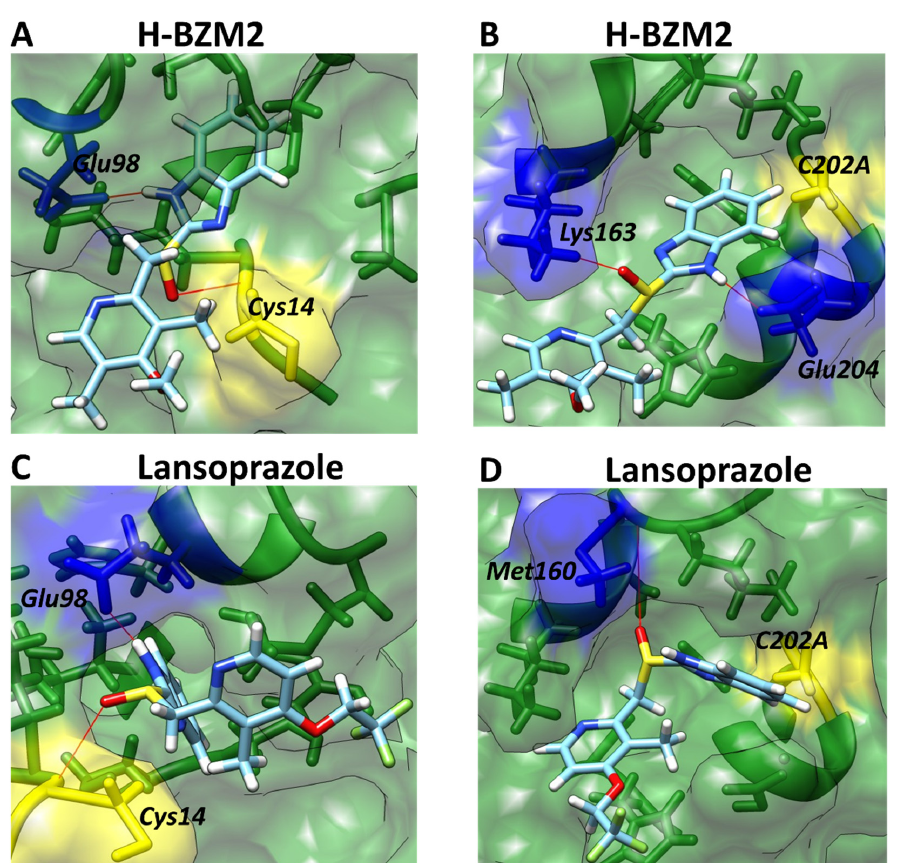
Figure 11. Prediction of docking between TPI protein (PDB entry 4BI7) and H-BZM2 and lansoprazole: 3D representations of the binding model of H-BZM2 in the vicinity of ( A ) Cys14 and ( B ) C202A, and of lansoprazole in the vicinity of ( C ) Cys14 and ( D ) C202A of TPI from G. lamblia . The interactions are shown in red, and Cys14 and C202A are shown in yellow.